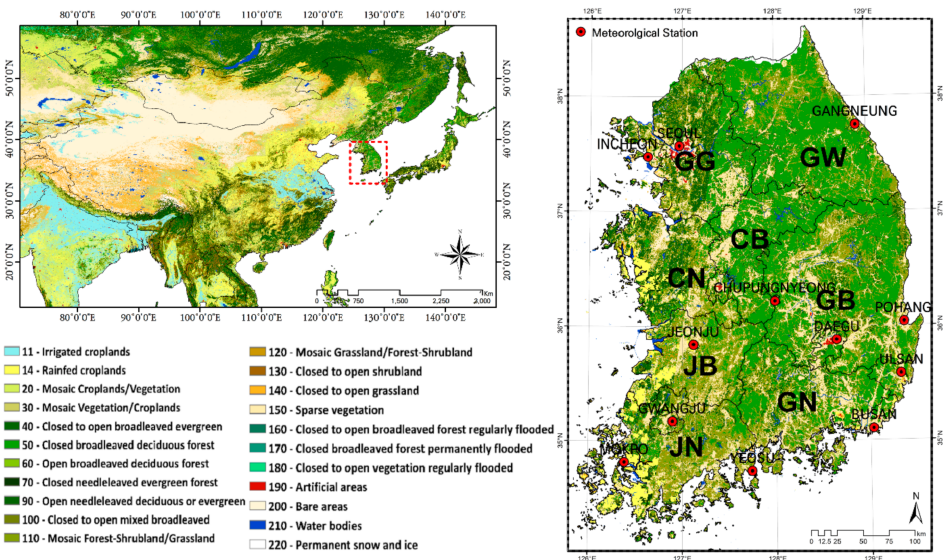
Figure 1. Location of South Korea on the eastern edge of the Asian continent (GG: Gyeonggi, GW: Gangwon, CN: Chungcheongnam, CB: Chungcheongbuk, JN: Jeollanam, JB: Jeollabuk, GN: Gyeongnam, GB: Gyeongbuk).